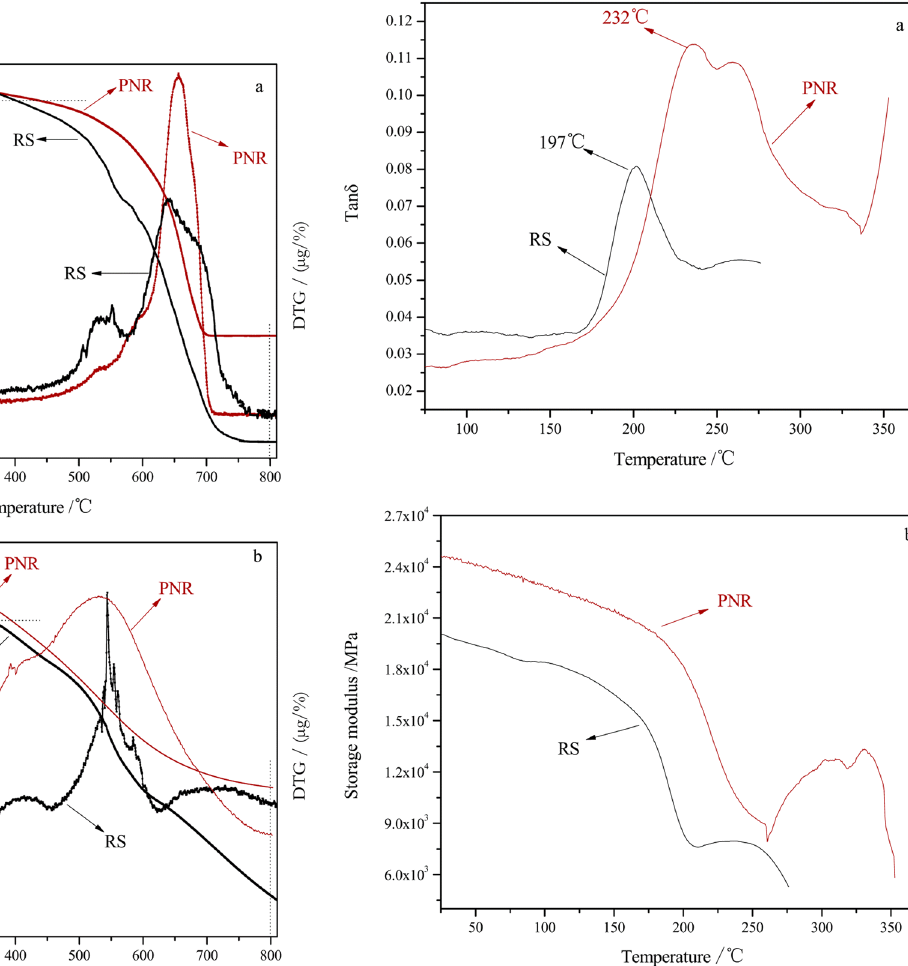
Figure 7: TGA curves of cured PNR and RS: ( a ) in air and ( b ) in N 2 .